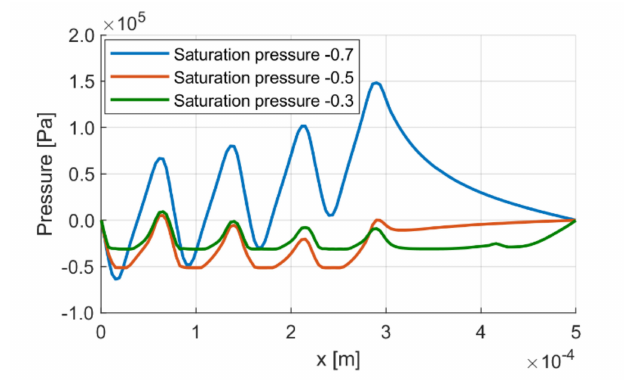
Figure 27. Pressure profiles calculated along the dimples median line at di ff erent saturation pressures. Square dimples with side 50 µ m and gap 8 µ m, sliding velocity 10 m / s. Set B of the cavitation coe ffi cients.